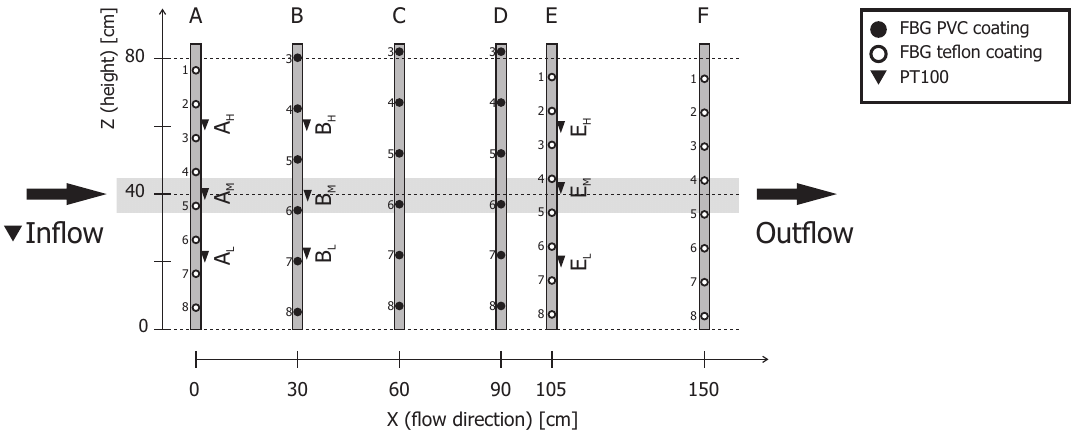
Figure 2. The position of the FBG fibers and PT100 sensors on the PVC frame: The top view. The data from the highlighted section are displayed in the results.